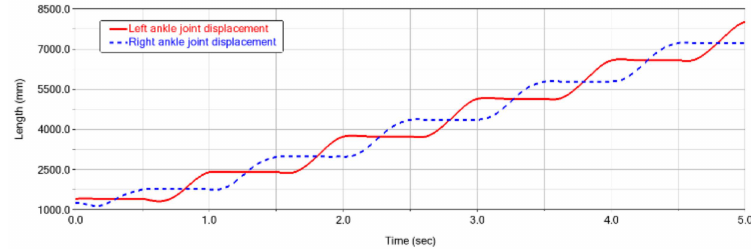
Figure 29. Foot displacement of lower extremity